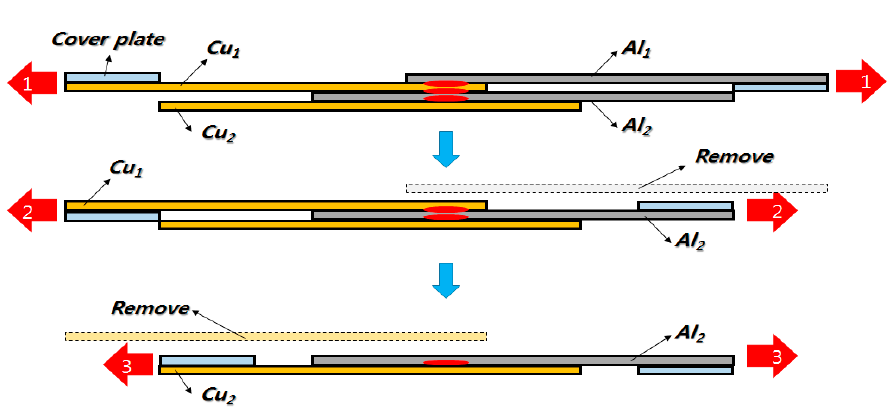
Figure 5. Procedure of multi-step shear strength test.